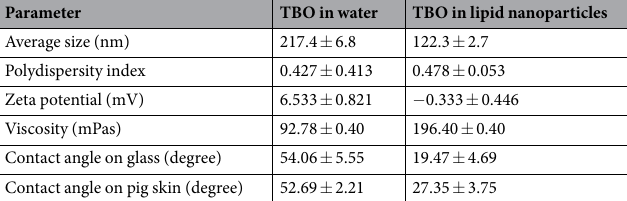
Table 1. Characterisation of TBO